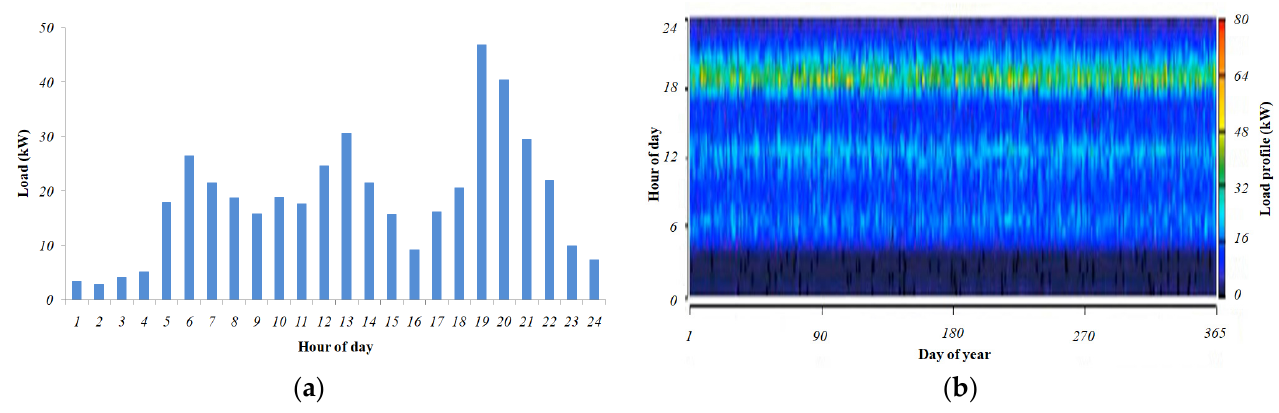
Figure 10. ( a ) 24 ‐ h load profile and ( b ) yearly load profile of 15 classrooms at SRM IST Delhi ‐ NCR Figure 10. ( a ) 24-h load profile and ( b ) yearly load profile of 15 classrooms at SRM IST Delhi- campus. NCR